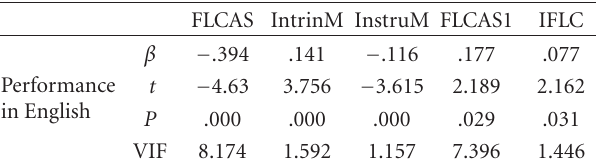
Table 4: Regression coe ffi cients and